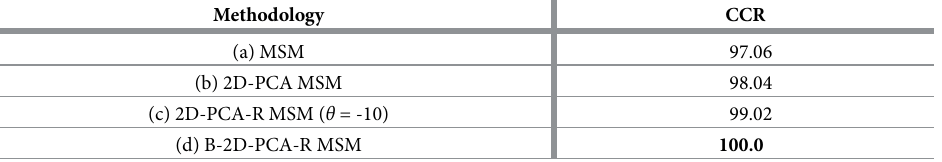
Table 1. Comparison of correct classification rate (CCR) [%] of each of MSM [12], the proposed 2D-PCA MSM, the proposed 2D-PCA-R MSM ( θ = − 10), and the proposed B-2D-PCA-R MSM on CASIA-C [14] (slow walk fs ).